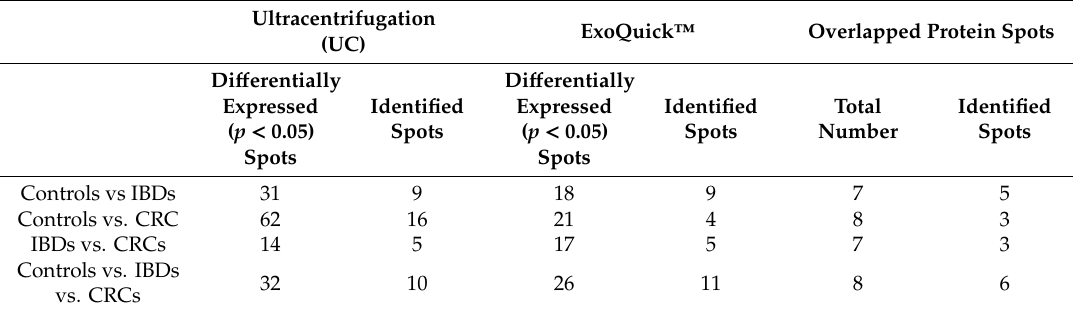
Figure 2. Supervised PCA plots based on 226 ( A ) and 93 ( B ) significant spots obtained by ultra-centrifugation or ExoQuick ™ . Red, proteins with higher expression isolated by ExoQuick ™ ; green, proteins with higher expression isolated via ultracentrifugation.